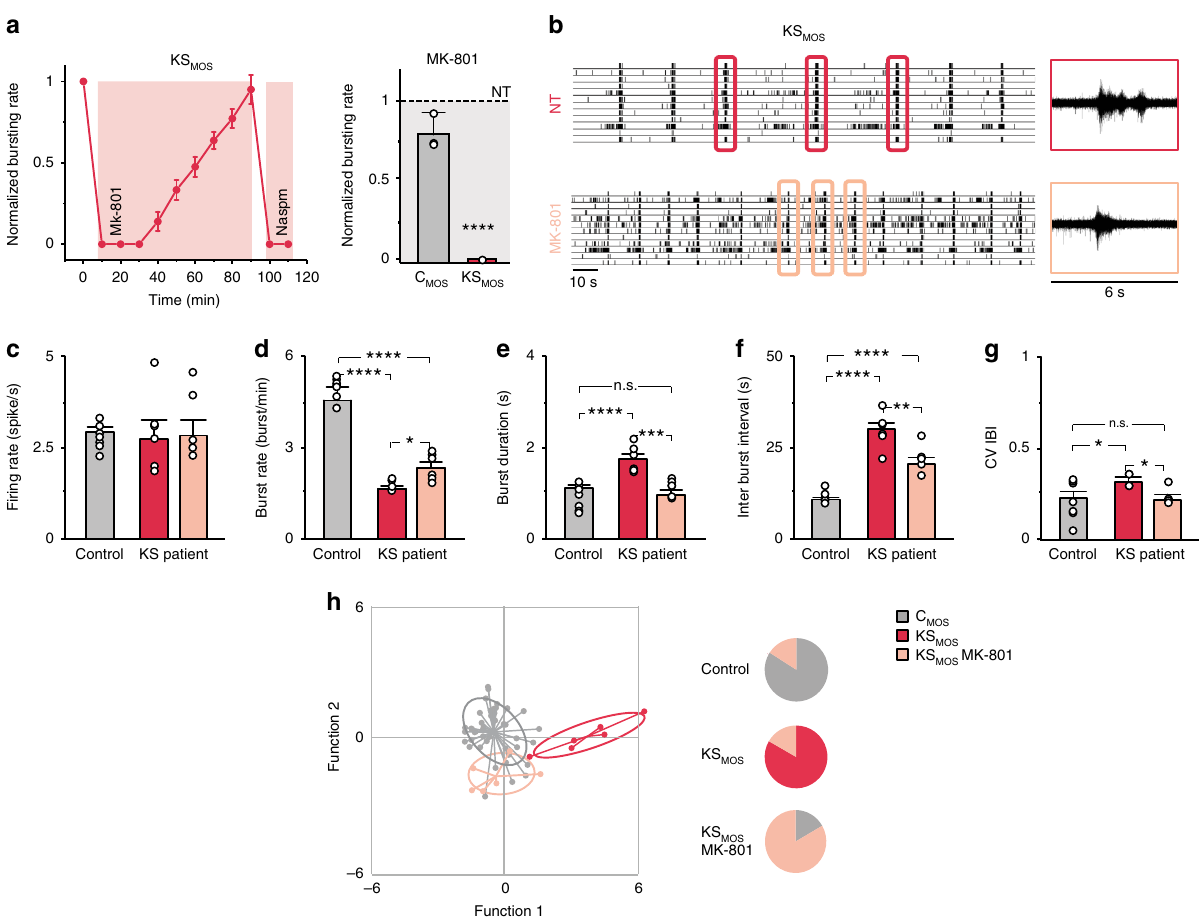
Fig. 7 NMDAR antagonist MK-801 rescues KS network phenotypes. a MK-801 (1 µ M) effect on KS MOS neuronal network activity (DIV 28). After 90 min, Naspm was added. Graph showing the effect of MK-801 (1 µ M) treatment on the neuronal network burst frequency for C MOS and KS MOS derived neuronal network 20 min after application. The values are normalized to the nontreated (NT) condition. b Representative raster plot showing the activity exhibited by KS patient-derived neuronal network (KS MOS ) grown on MEAs either nontreated or after one week of treatment with MK-801. Six second of raw data showing a burst recorded from a representative channel are shown for the NT and the treated conditions. c – g Quanti fi cation of network properties as indicated, n = 8 for C MOS ; n = 6 for KS MOS and n = 6 for KS MOS treated with MK-801. h Canonical scores plots based on discriminant analyses for